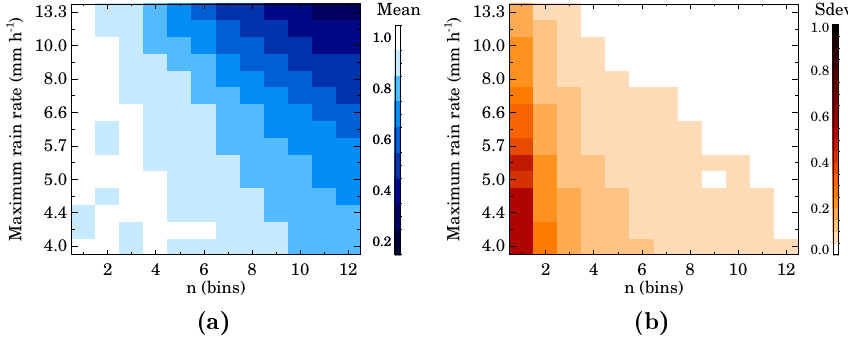
Figure 4. Mean (a) and standard deviation (b) of the correction factor C − 1 Carlo simulations including 100 repetitions with random measuring error. The Monte Carlo simulations are performed for combinations of 15 different intensities of the homogeneous precipitation field and 12 considered interval widths (2 n + 1) (cid:49)r for attenuation determination above R 3 .